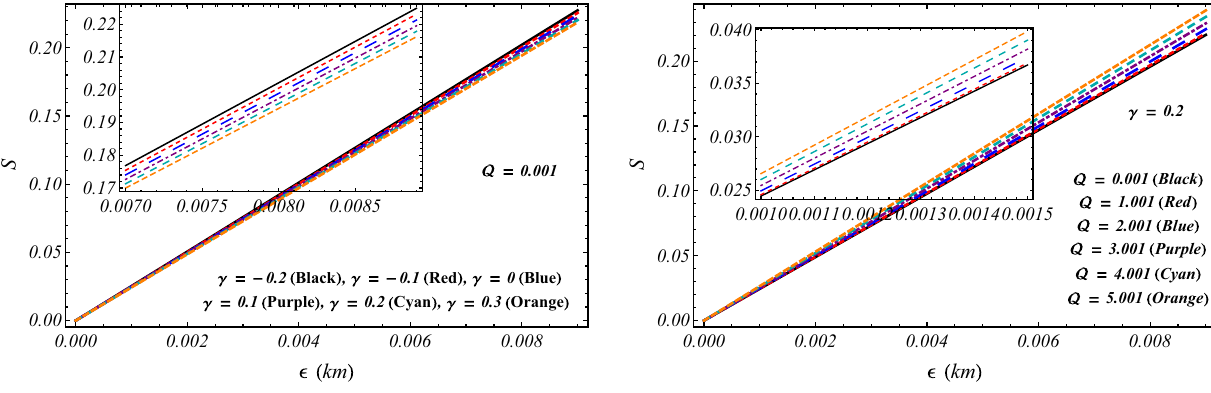
0.0070 0.0075 0.0080